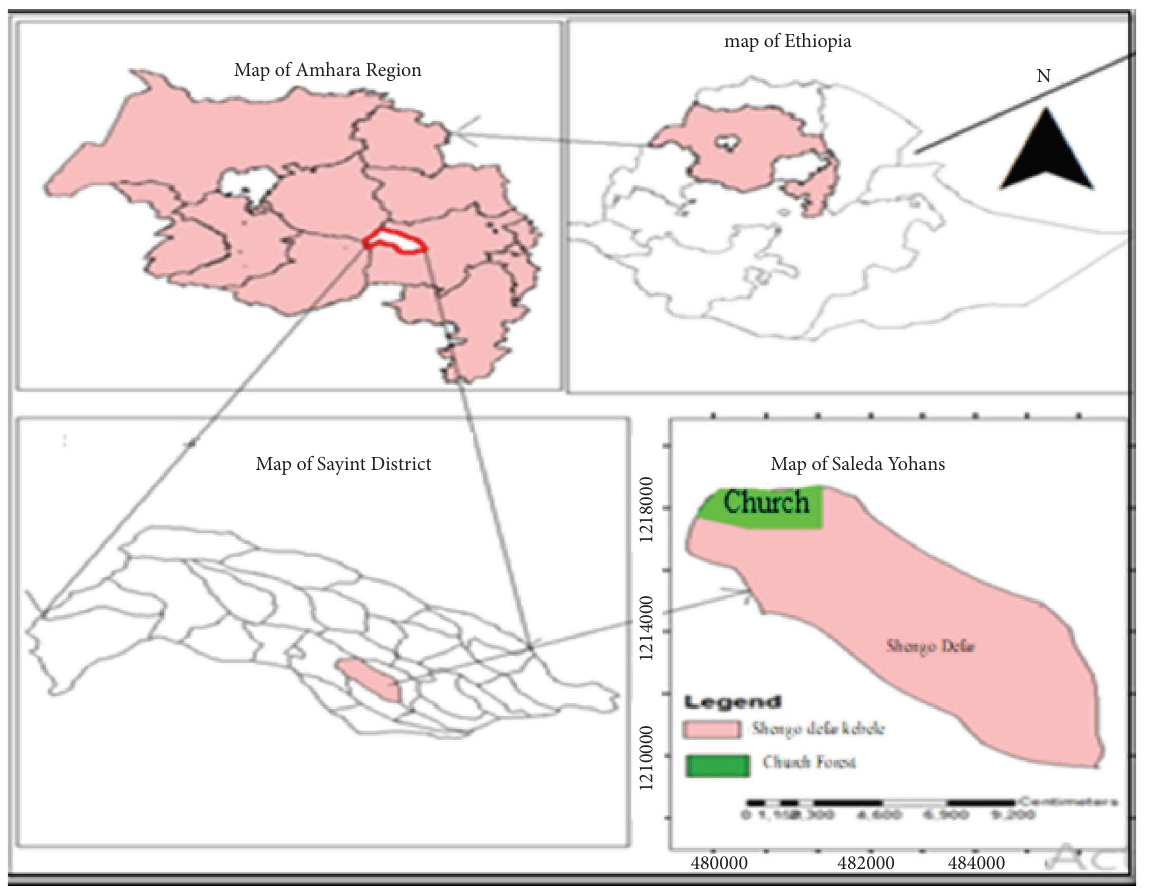
Figure 1: Te study area map.